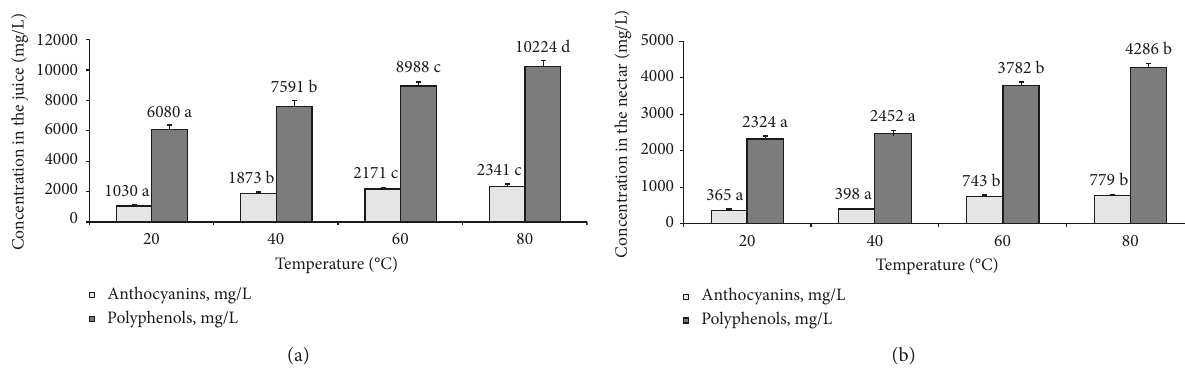
Figure 3: Influence of treatment temperature on polyphenol and anthocyanin content of aronia fruit juices (a) and fruit nectars (b). Results are presented as mean values from all samples ± SD. There are no significant differences among values marked with the same letters in individual groups. Table 4: Polyphenol content (mg/l) and composition of aronia fruit juices and nectars obtained at different temperatures.